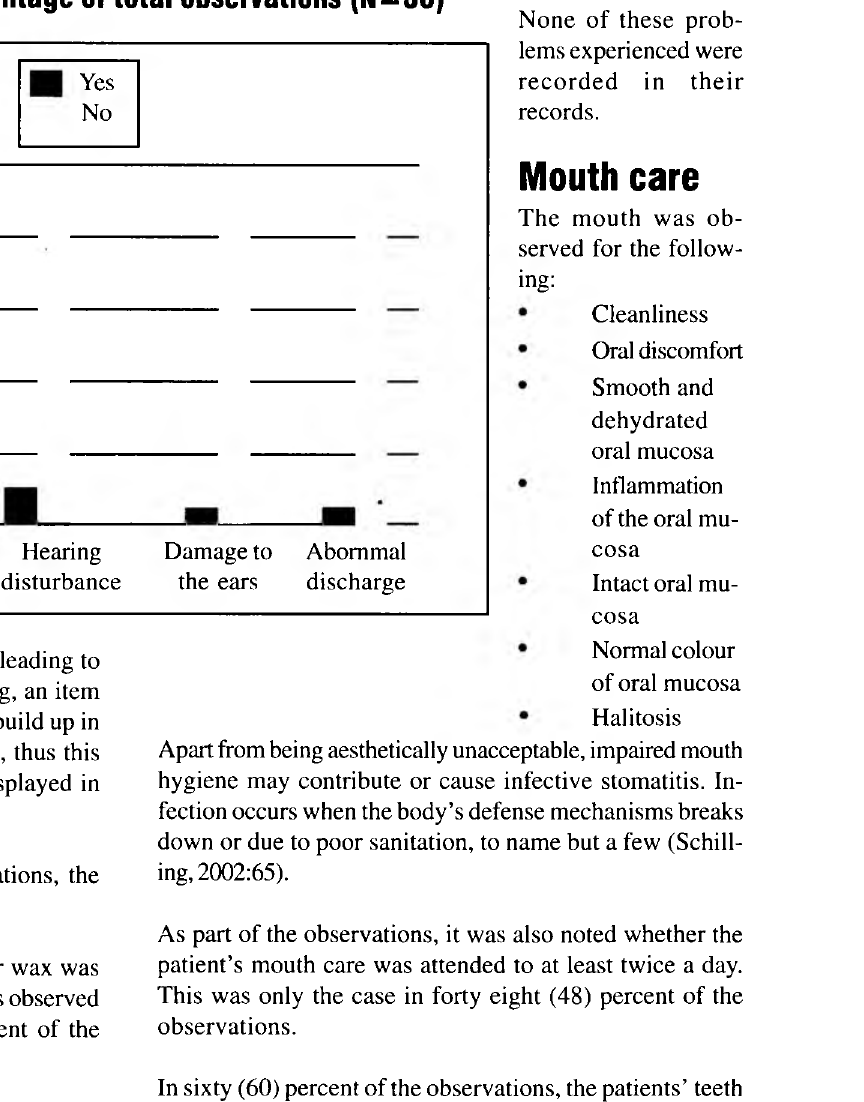
Figure 4 : Outcome of mouth care as percentage of total